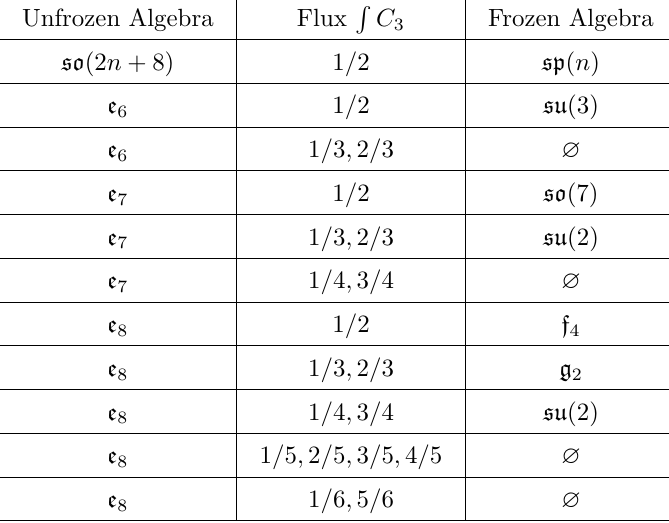
Table 5 . The frozen singularities in the context of the compactification of M-theory on K3 [51, 71]. These have to be combined in all possible ways to form a K3 with singular